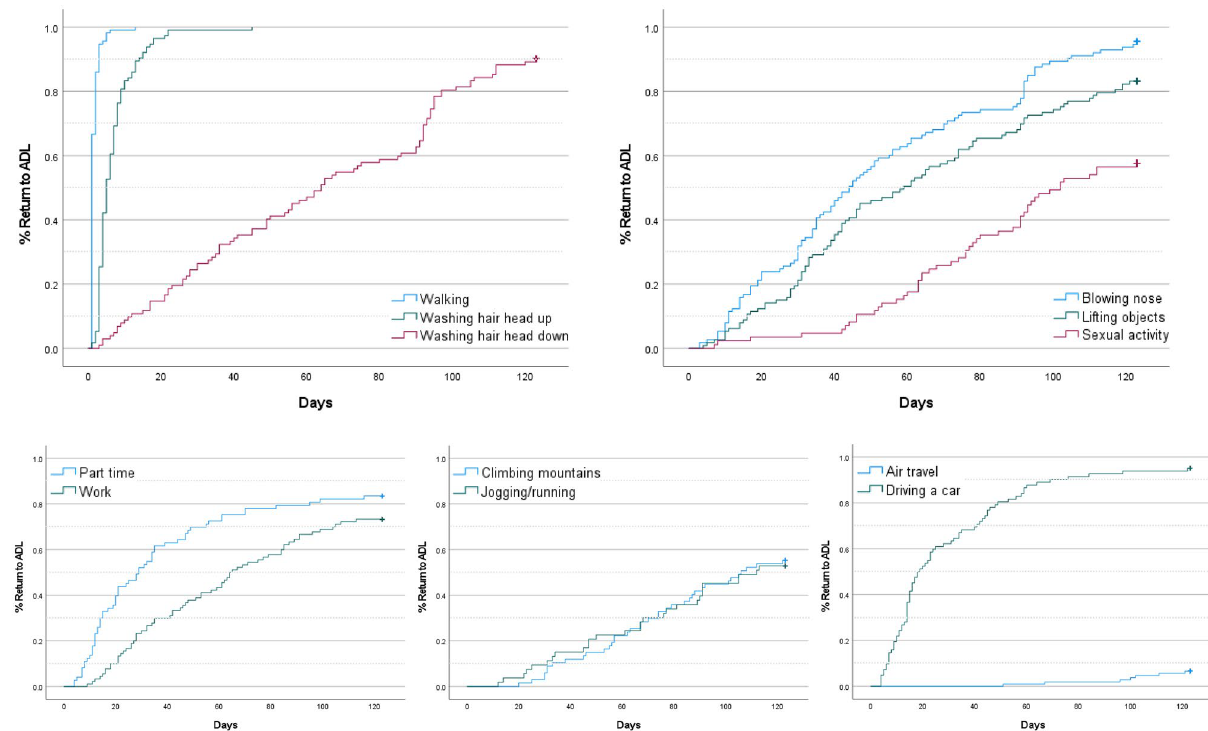
Figure 2. Percentage of return to ADL after surgery. The graphs illustrate the return rates according to the time elapsed after surgery for representative BADL ( A ) and IADL ( B )